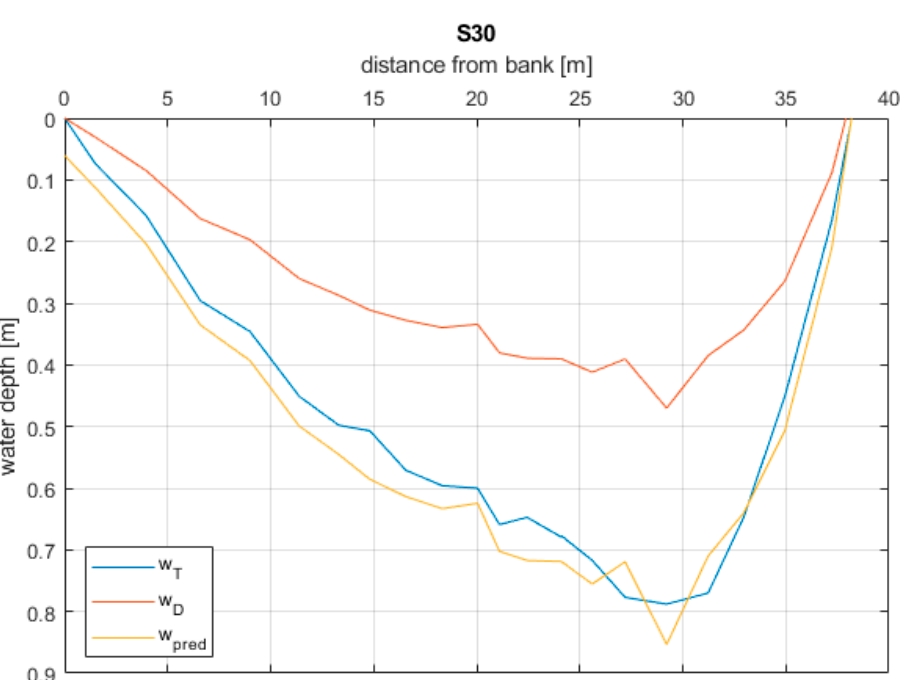
Figure 12. Topographic water depth (blue), digital points water depth (red), predicted points water depth (yellow)—cross-section S30.